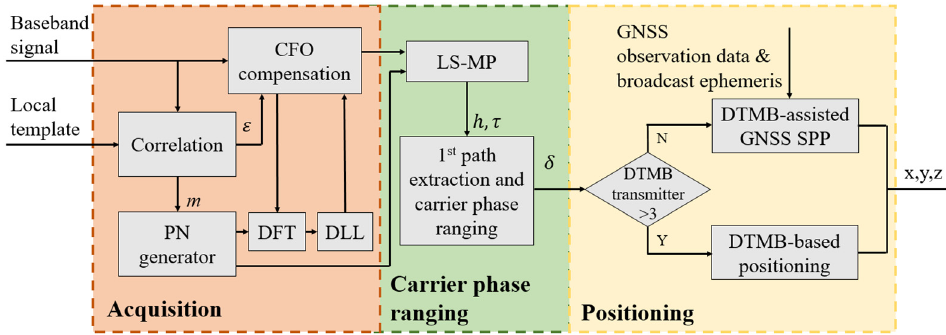
Figure 2. Block diagram of the proposed ranging and positioning method.